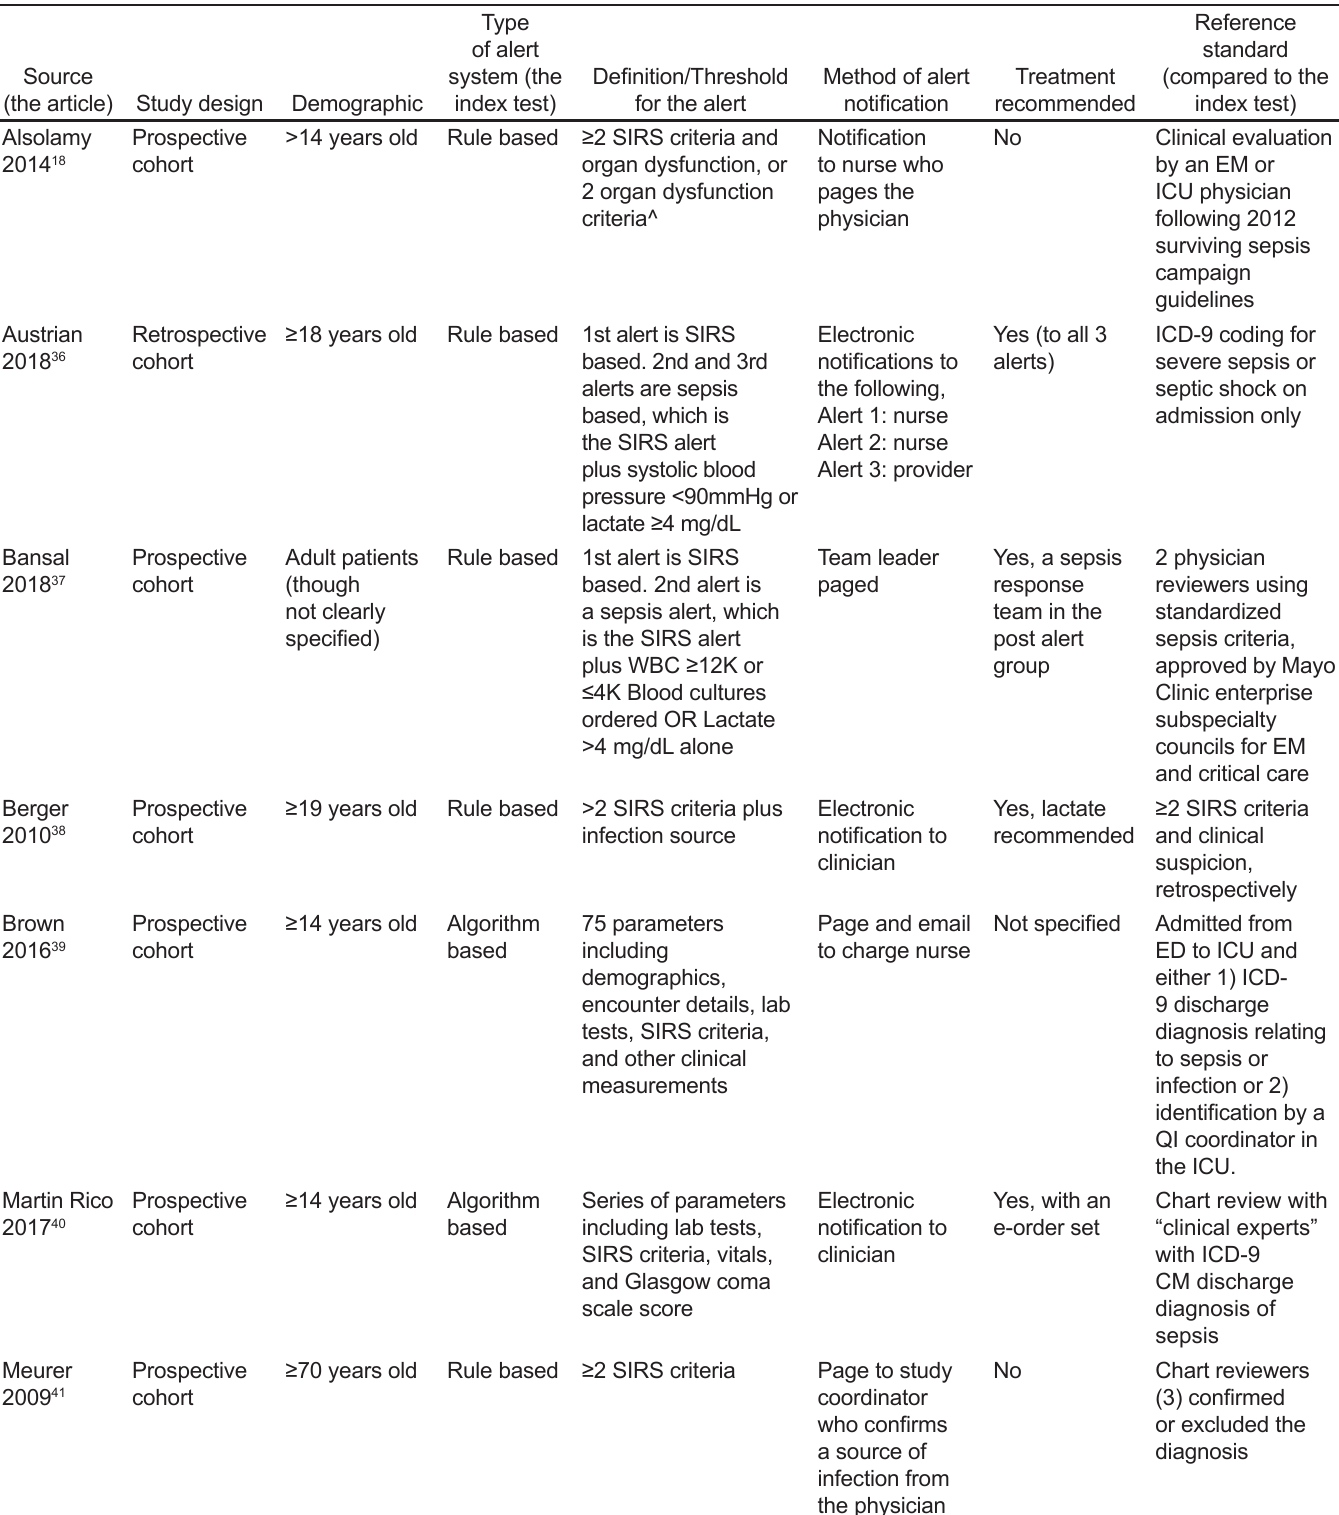
Table 1. Characteristics of included